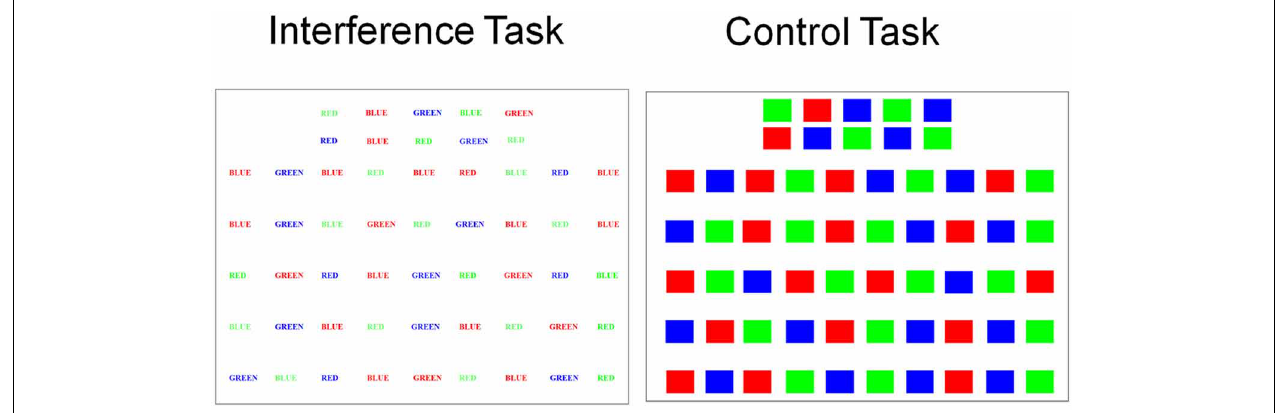
FIGURE 2 | Examples of stimuli used for the Stroop interference (color words red, blue, and green printed in incongruent ink) and control (rectangles printed in red, blue, or green)